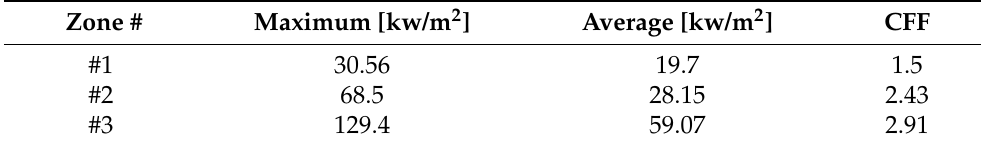
Figure 22. Zones definition to identify the local CFF in the radiant section. Table 17. CFF values at the three locations of the radiant section.